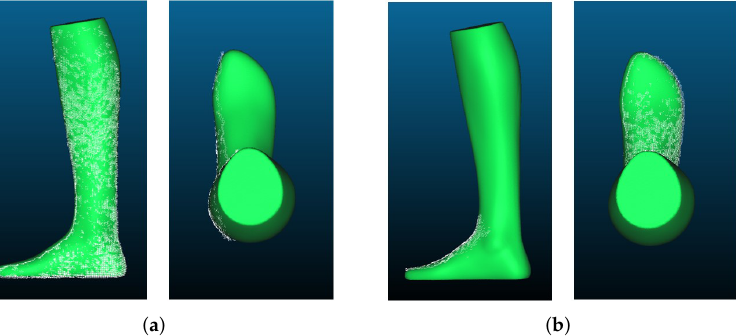
Figure 18. Filtered point clouds recorded with Kinect Azure placed over the GT: ( a ) filtered length reconstruction; ( b ) filtered width